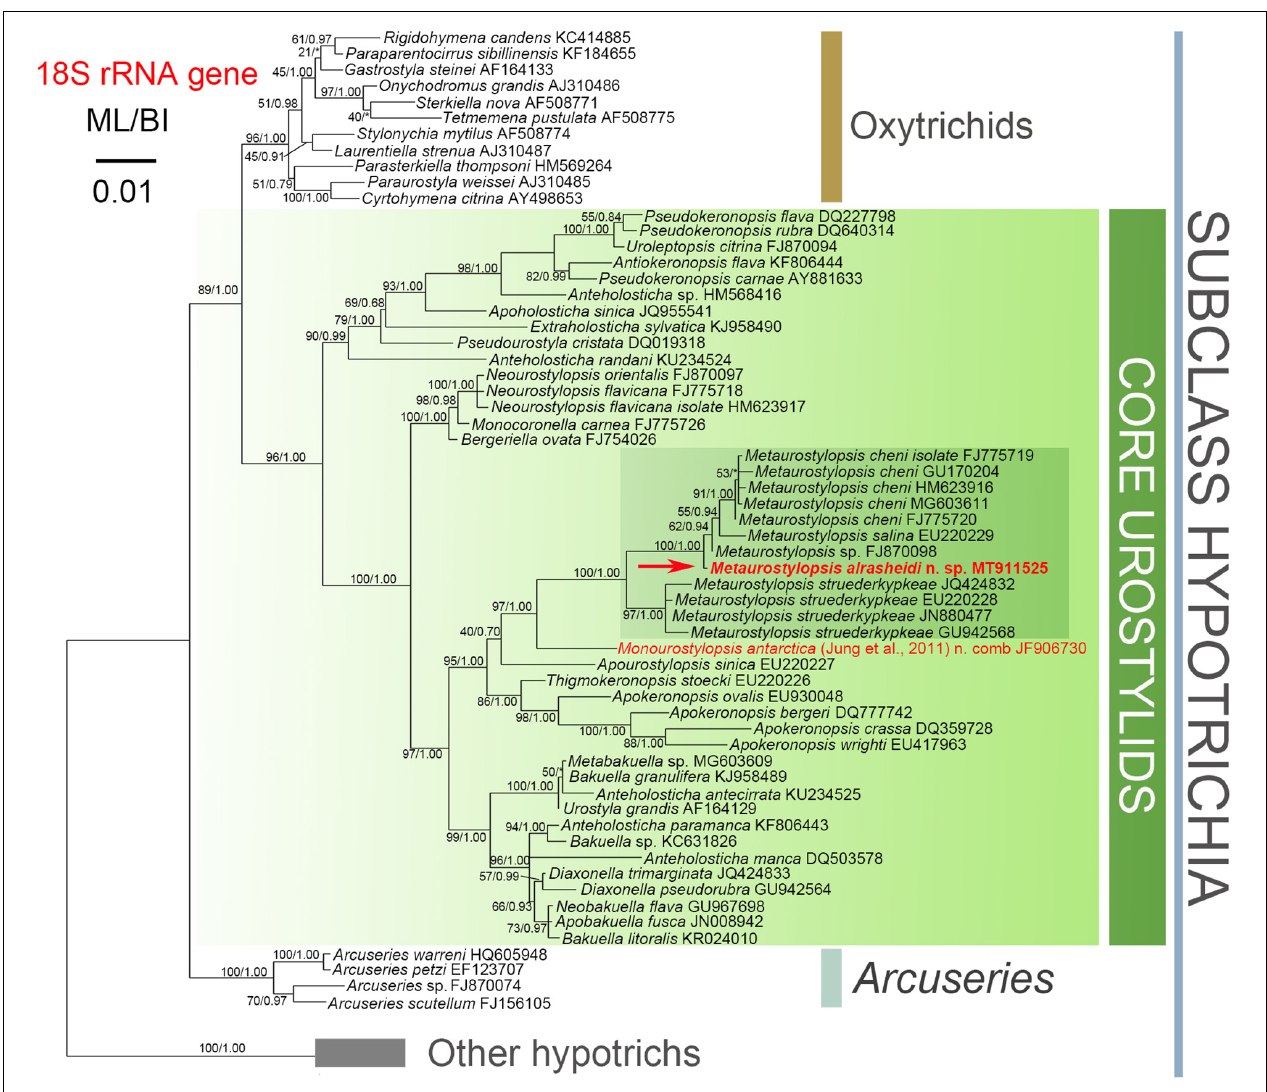
FIGURE 7 | Maximum likelihood (ML) phylogenetic tree with 18S rRNA gene as gene marker. The newly characterized sequence is in red (arrow). Numbers near nodes represent bootstrap values of ML and posterior probability values of Bayesian inference (BI), respectively. Asterisks (*) indicate the disagreement between ML and BI. The scale bar represents 1 substitution for every 100